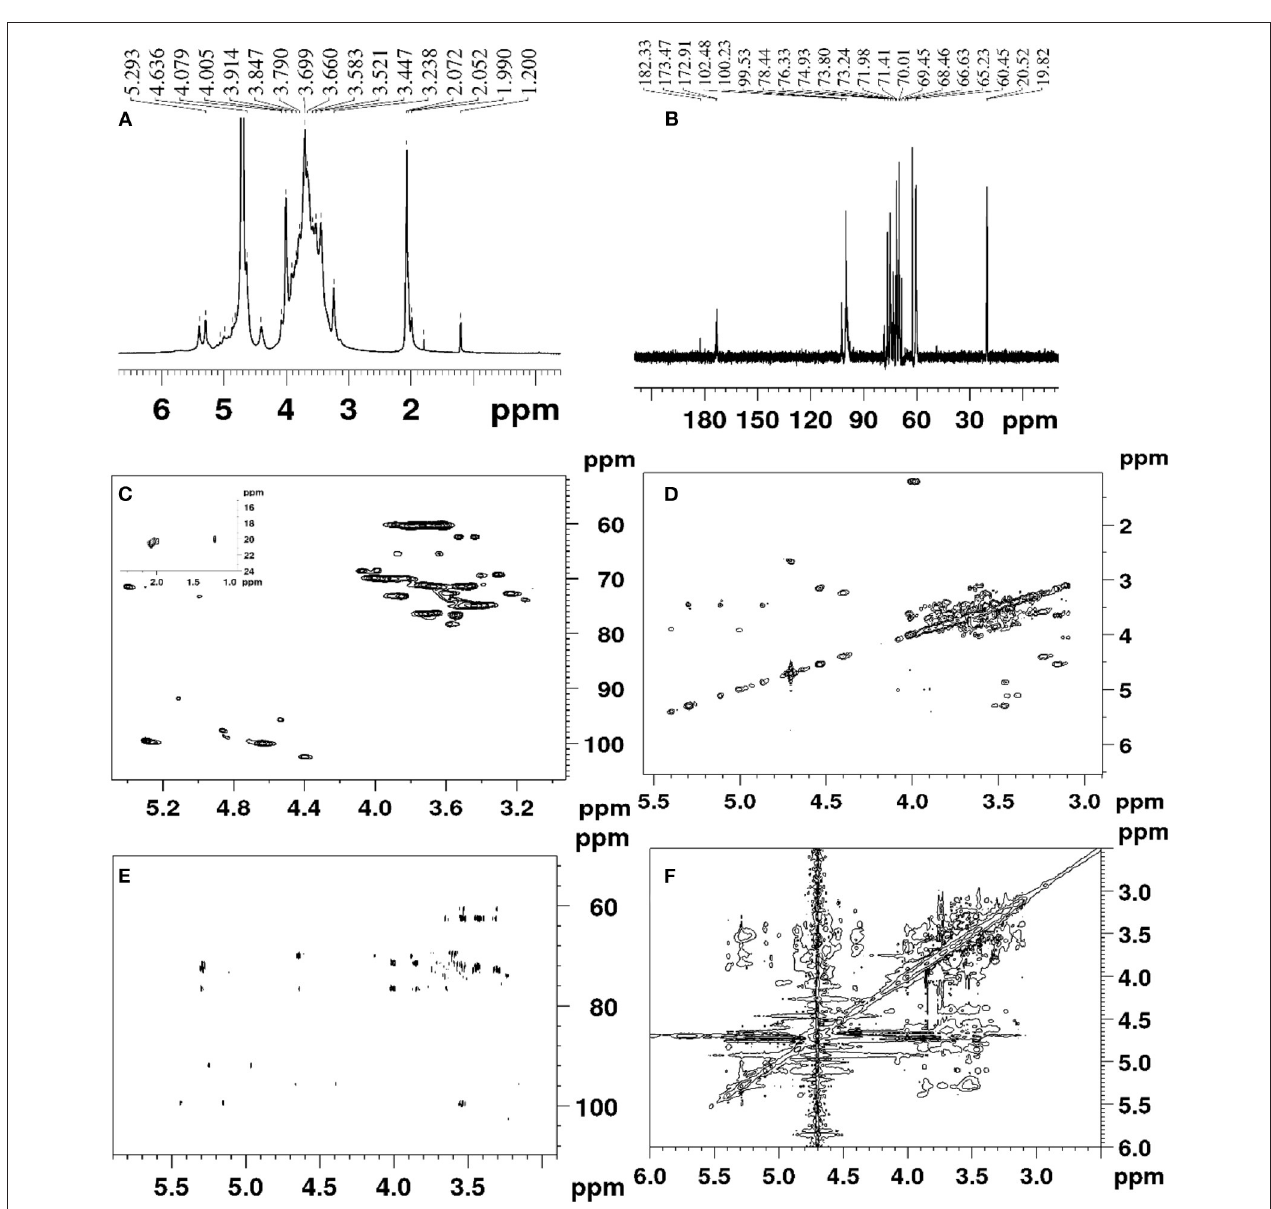
FIGURE 2 | The spectra of DHPs-1: (A) 1 H; (B) 13 C; (C) HSQC; (D) COSY; (E) HMBC; (F) ROESY.